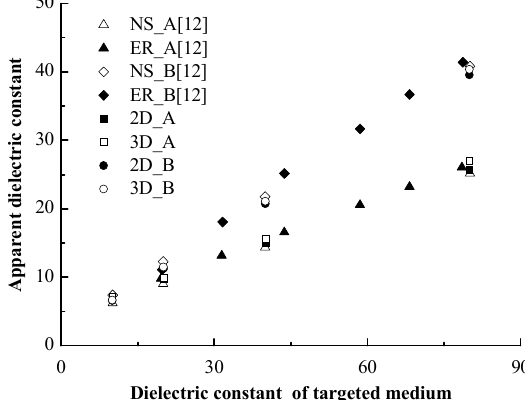
Figure 7. Comparison of measurement sensitivity of the TDR probes obtained from numerical simulation (NS) and experimental results (ER). NS_A, ER_A, NS_B, and NS_B represent data obtained from numerical simulation and experimental results using type A and B probes, respectively, as reported by Zhan et al. (2015). Furthermore, 2D_A, 3D_A, 2D_B, and 3D_B represent data separately obtained from two- and three-dimensional numerical simulations using type A and B probes, respectively, in this